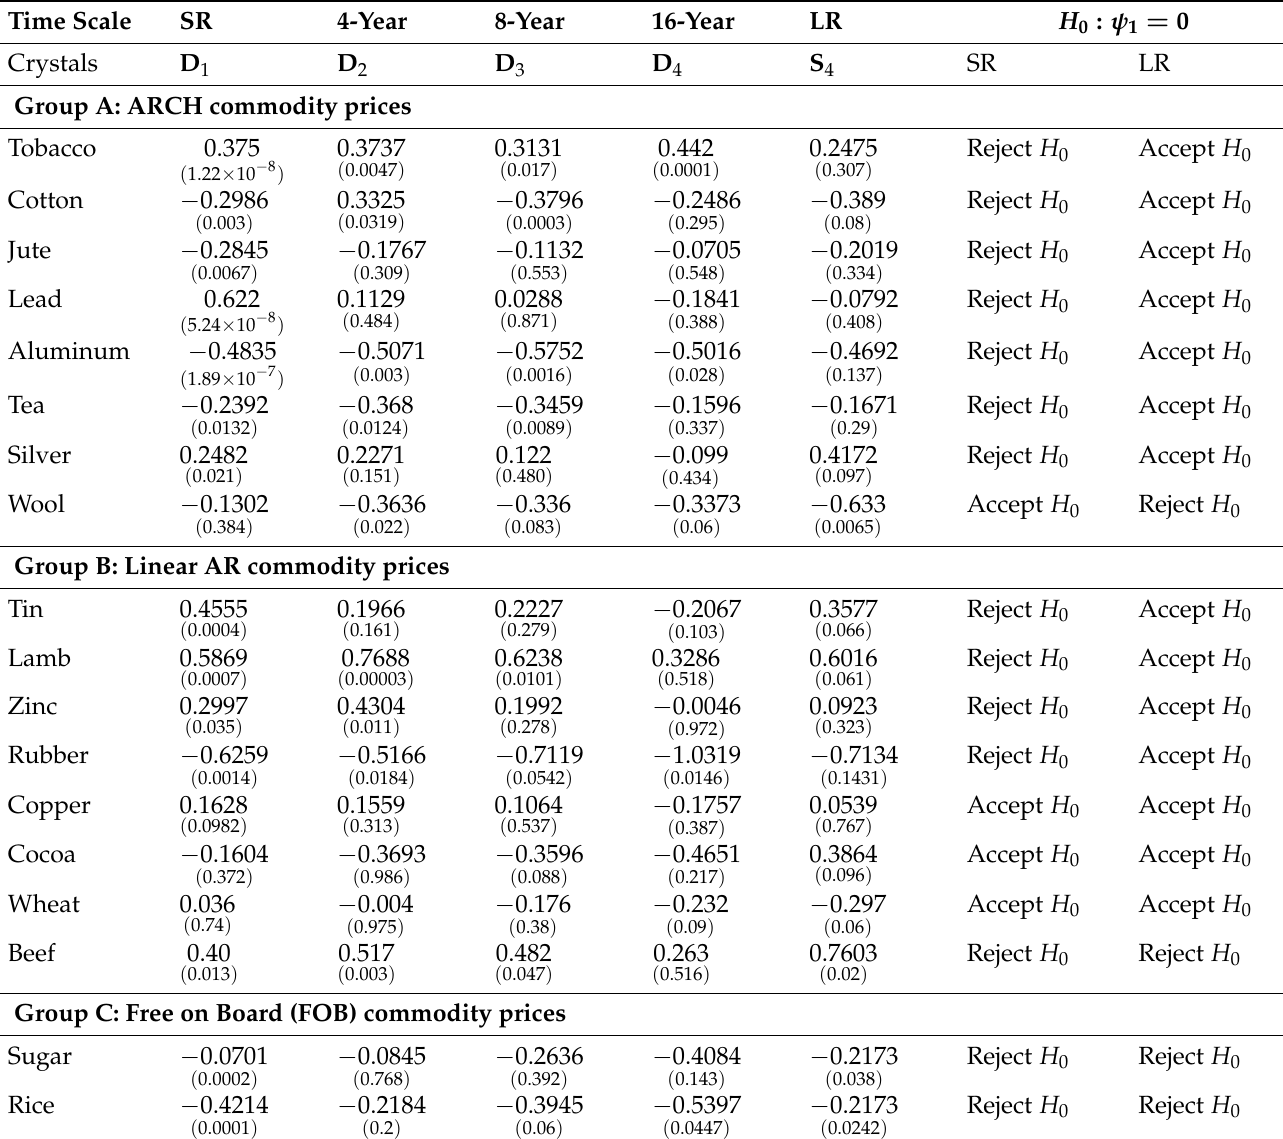
Table 3. Multiresolution decomposition of logarithm of real individual commodity prices in the Grilli and Yang data set. The reported values are the least squares estimates of the slope coefficients in Equation (6). The p-values are reported in brackets underneath the coefficients. DF denotes the degrees of